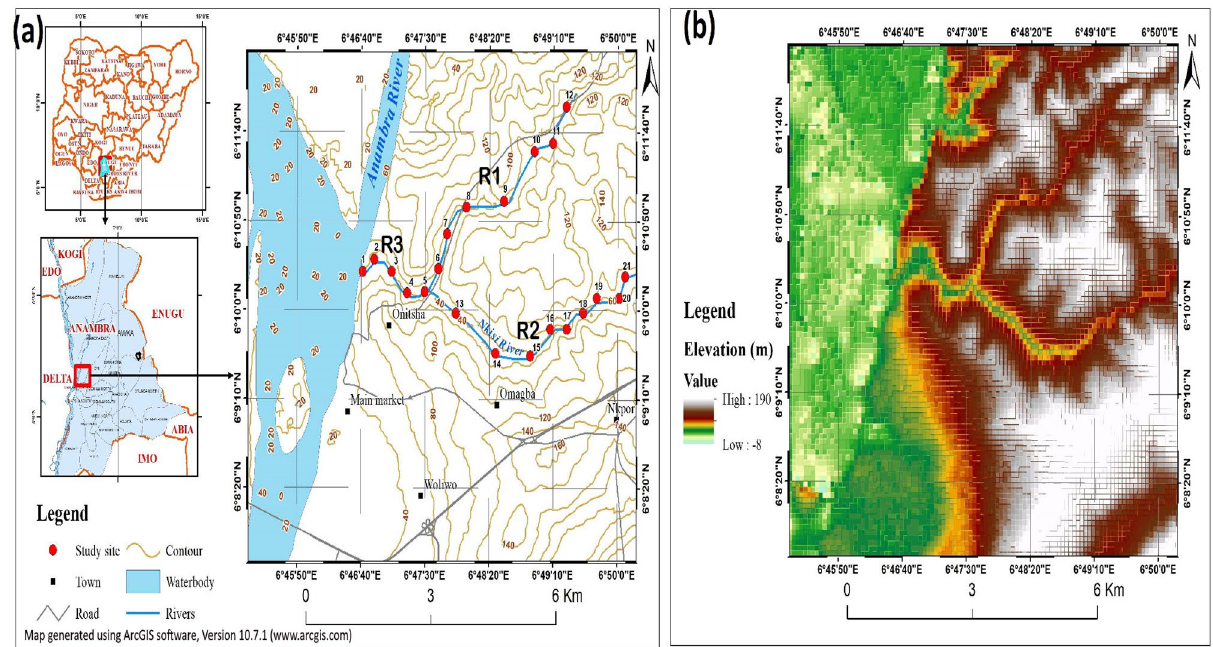
Figure 1. ( a ) Location of Nkisi River watershed in Anambra State (Nigeria) showing the study sites and ( b ) the digital elevation model of the study area. R1 , R2 and R3 represent Reach 1 , Reach 2 and Reach 3 , respectively. The figure was generated by using an ArcGIS software (version 10.7.1). One of the spatial analysis tools (contour tool) in the ArcGIS software was used to generate contour lines from a 30-m DEM image of the study area which was downloaded from the United States Geological Survey website (https:// earth explo rer. usgs. gov/). The study locations overlying the map was obtained from the field using a GPS device (model no: Garmin eTrex sorted silty clay with occasional gravel that changes to well-sorted gravelly sand containing less than 10% fines at the river mouth. The upper reaches of the river channel are deeply incised and have been undergoing acceler- ated bank erosion due to numerous anthropogenic stresses, including deforestation, sand mining, agricultural intensification (row crop farming), and rapid urbanisation. Soil sampling and geotechnical analysis. A total of 47 undisturbed soil cores were recovered from the study area using standard U4 soil samplers. Two representative soil cores were recovered along a vertical section at each of the study sites in Reach 1 and Reach 2 , respectively. In contrast, three representative soil cores were recovered along a vertical axis in all the 5 study sites in Reach 3 . The soil samples were obtained at a vertical spacing that ranged from 0.5 to 3 m depending on bank height. Similarly, 21 soil samples were collected from the talus materials at the bank toe to evaluate changes in their geotechnical and sedimentological properties. Lithologic characterisation of the streambanks was achieved by subjecting the soils to geotechnical tests, such as the Atterberg limits test, grain-size distribution analysis, unconsolidated undrained (UU) triaxial test, and phase relationship tests. All the tests were carried out following specific ASTM standards. Further information